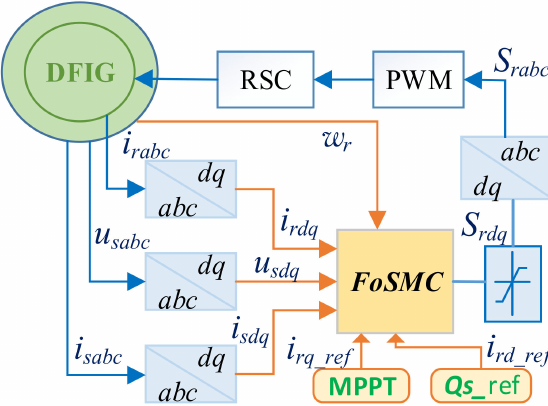
Figure 14. Conventional first-order SMC scheme.